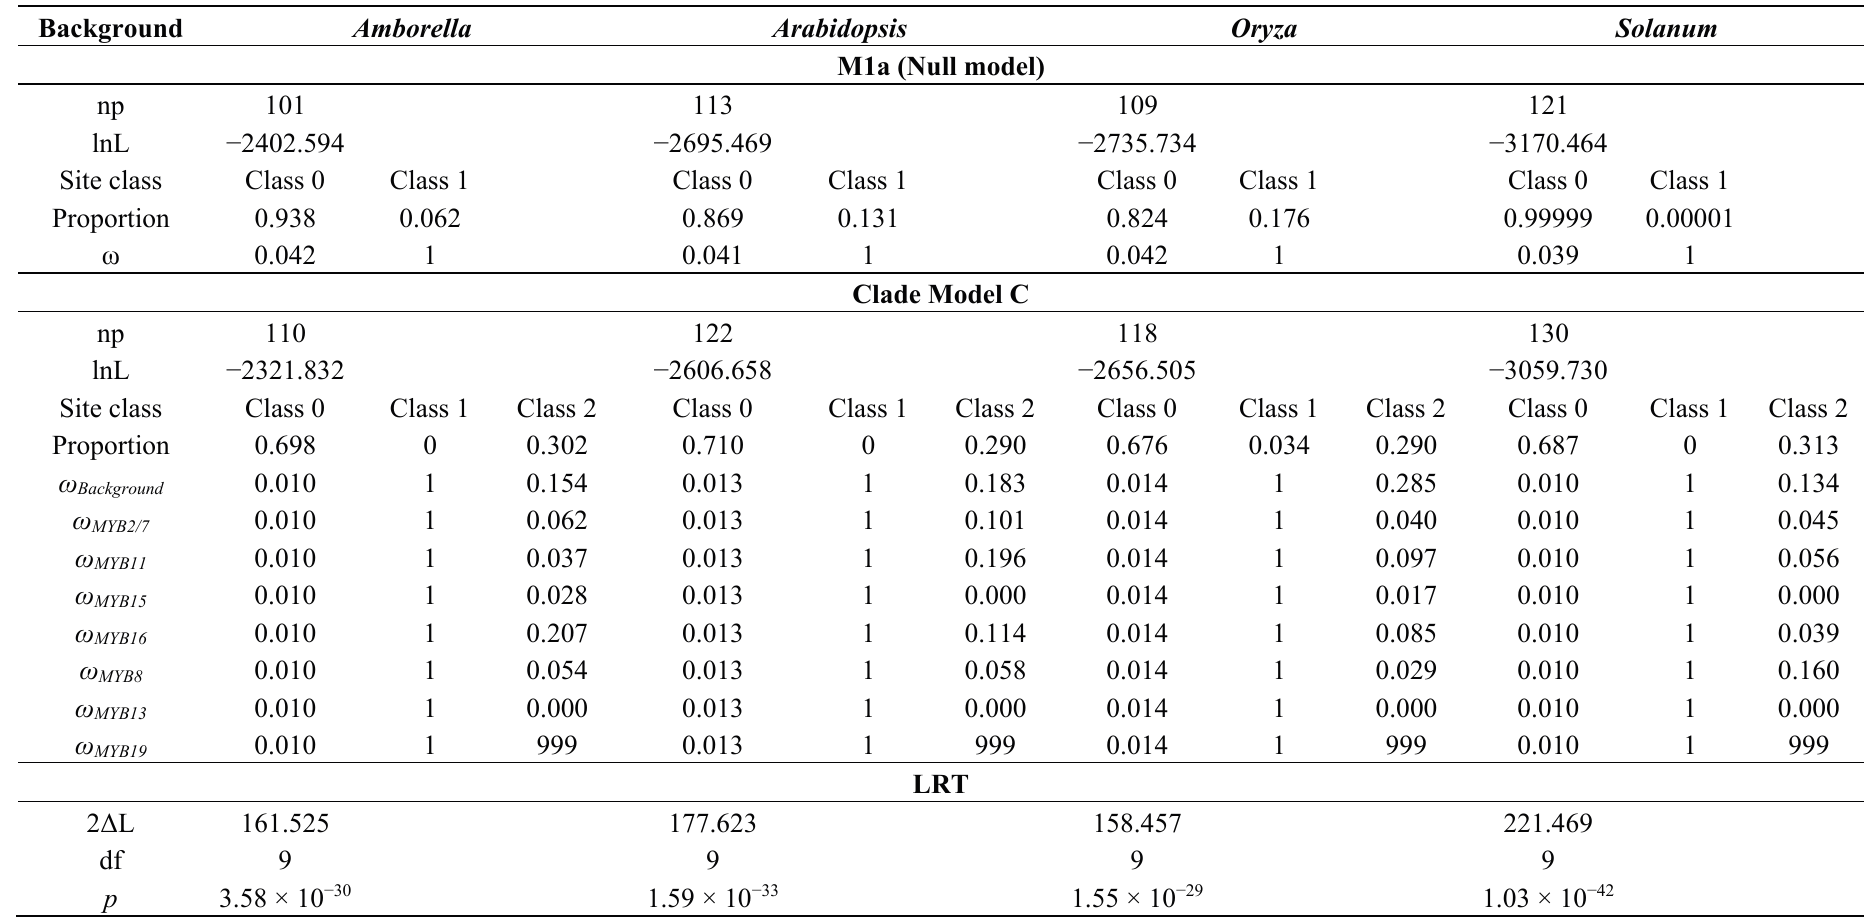
Table 5. Results of clade model analyses and the likelihood ratio